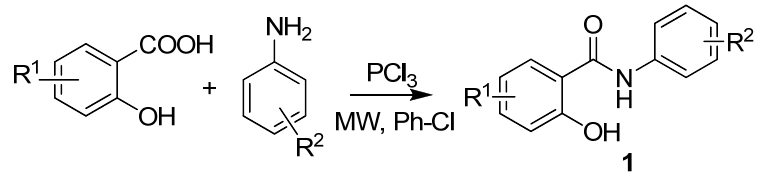
Scheme 1. Synthesis of salicylanilides.